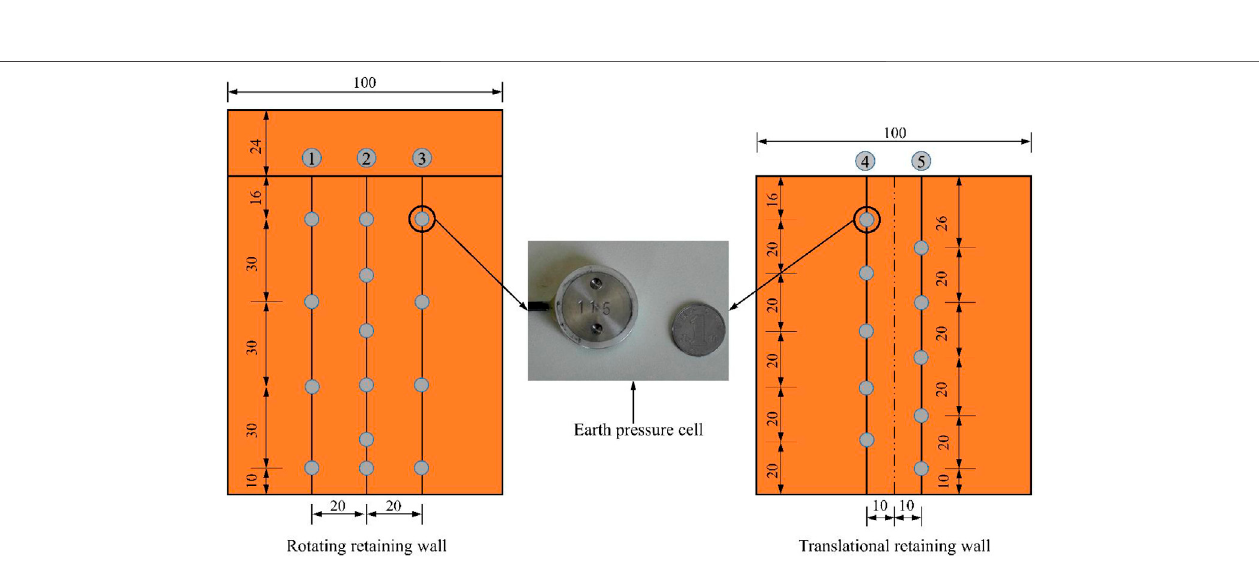
FIGURE 2 | Diagram of earth pressure cell